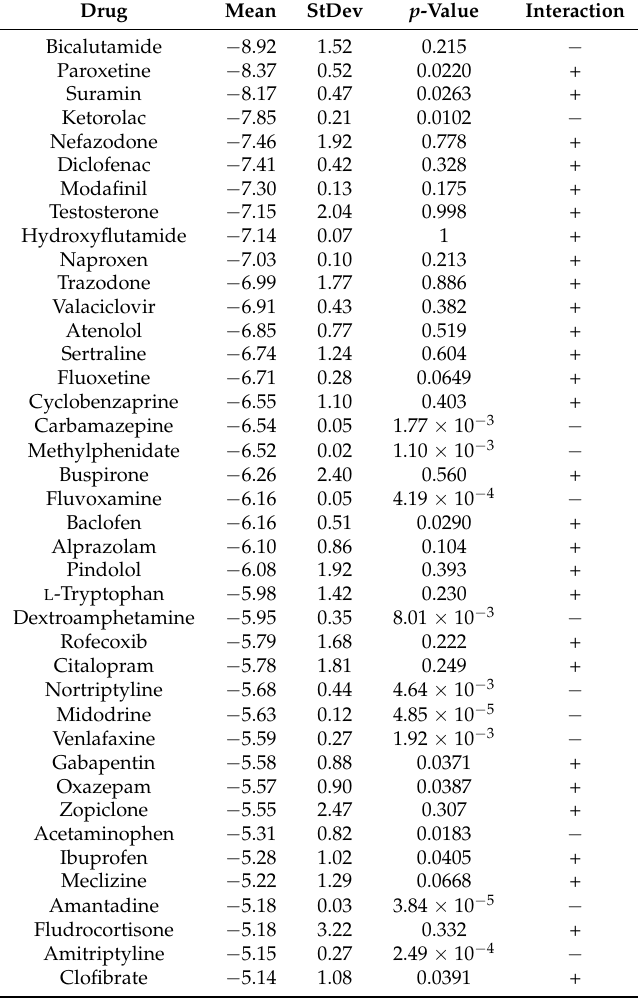
Table 6. Interaction of common drugs used to treat GWI symptoms with the AR antagonist form. Mean binding energy and standard deviation are in units of kcal/mol. A t -test was used to compare with the known binder hydroxyflutamide. (+) indicates putative binding, ( − ) indicates no putative